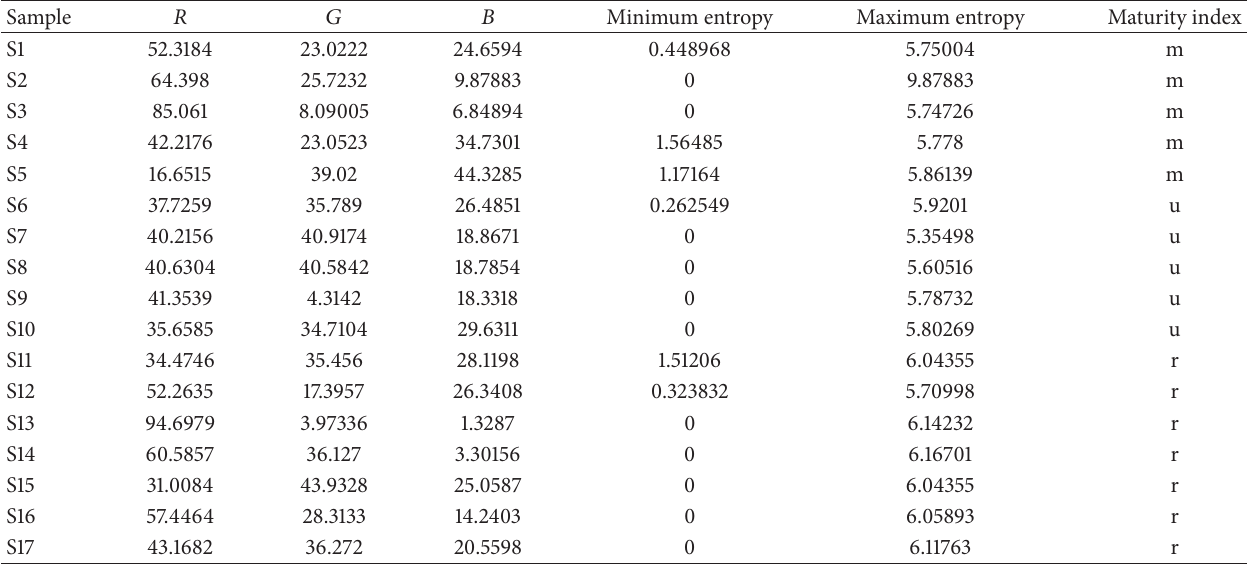
Table 3: Preliminary extracted parameters for maturity index assessment.